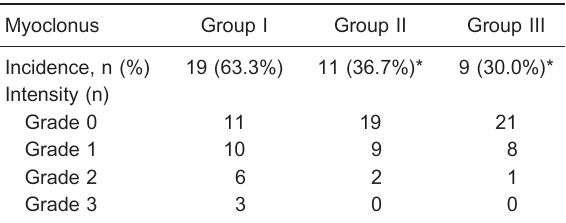
Table 2. Comparison of incidence and severity of myoclonus among the 3 groups. Myoclonus